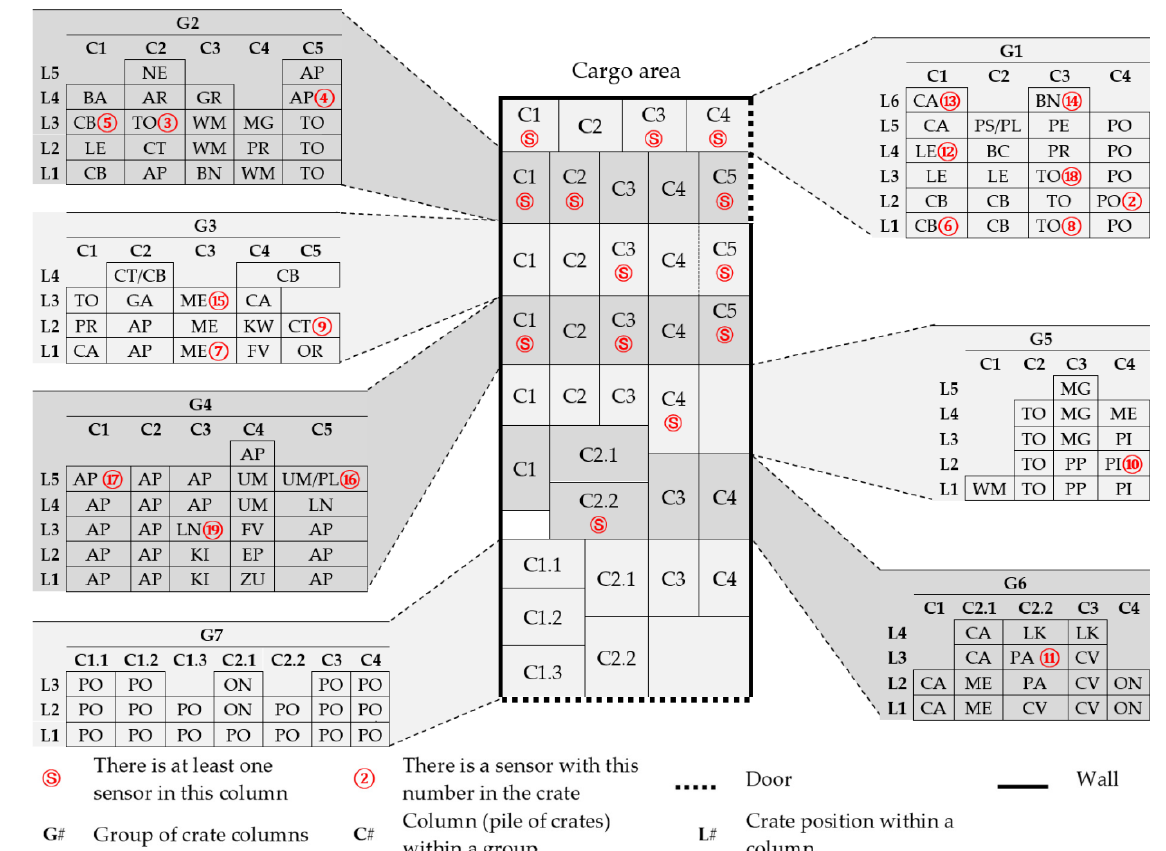
Figure 6. Placement of sensor 3.